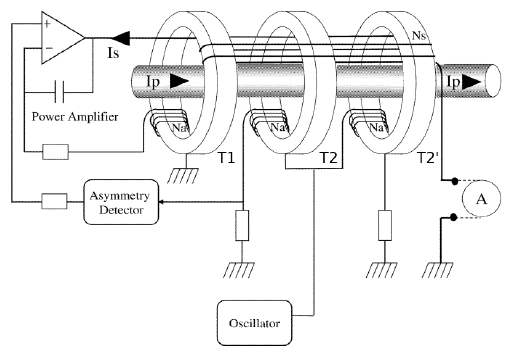
Figure 2. Block diagram of MACC zero-flux DCCT. c (cid:13) 2002 IEEE. Reprinted with permission from [14]. T1 as AC transformer, T2 and T2’ as balanced zero-flux sensor, I p as primary current to be